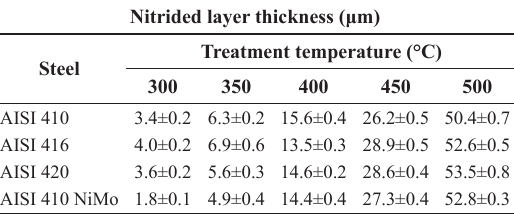
Table 2. Nitrided layer thickness for all studied steels and